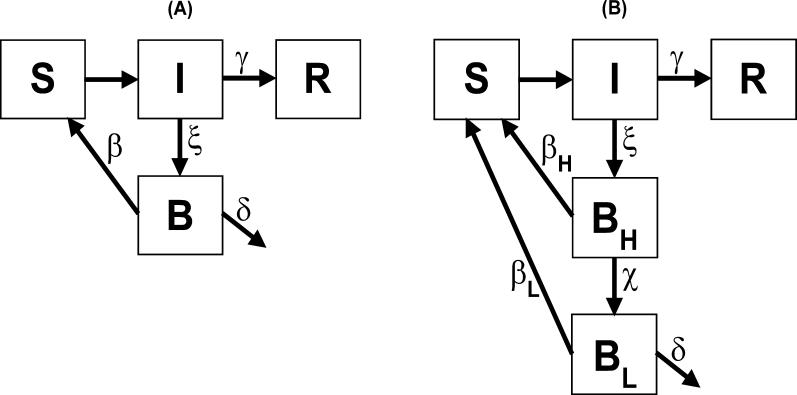
Models of Cholera Transmission(A) Model of cholera transmission, neglecting a HI state of V. cholerae. Simple model reflecting a picture of contagion in which susceptibles (S) become infectious (I) after consuming concentrations (shown by B) of V. cholerae. Individuals may achieve a transient immunity (R) after recovery.(B) Model of cholera transmission, incorporating a HI state of V. cholerae. This model includes contagion of V. cholerae that is HI (H) for a brief time after shedding and decays into a state of lower infectiousness (L). Greek letters denote rates of transitions between the different states, as described in Table 1.